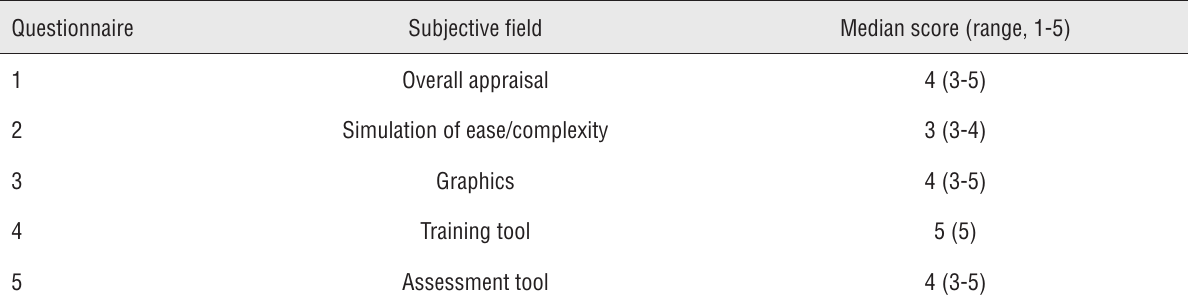
Table 1 - Results of face and content validity (experts). Questionnaire Subjective